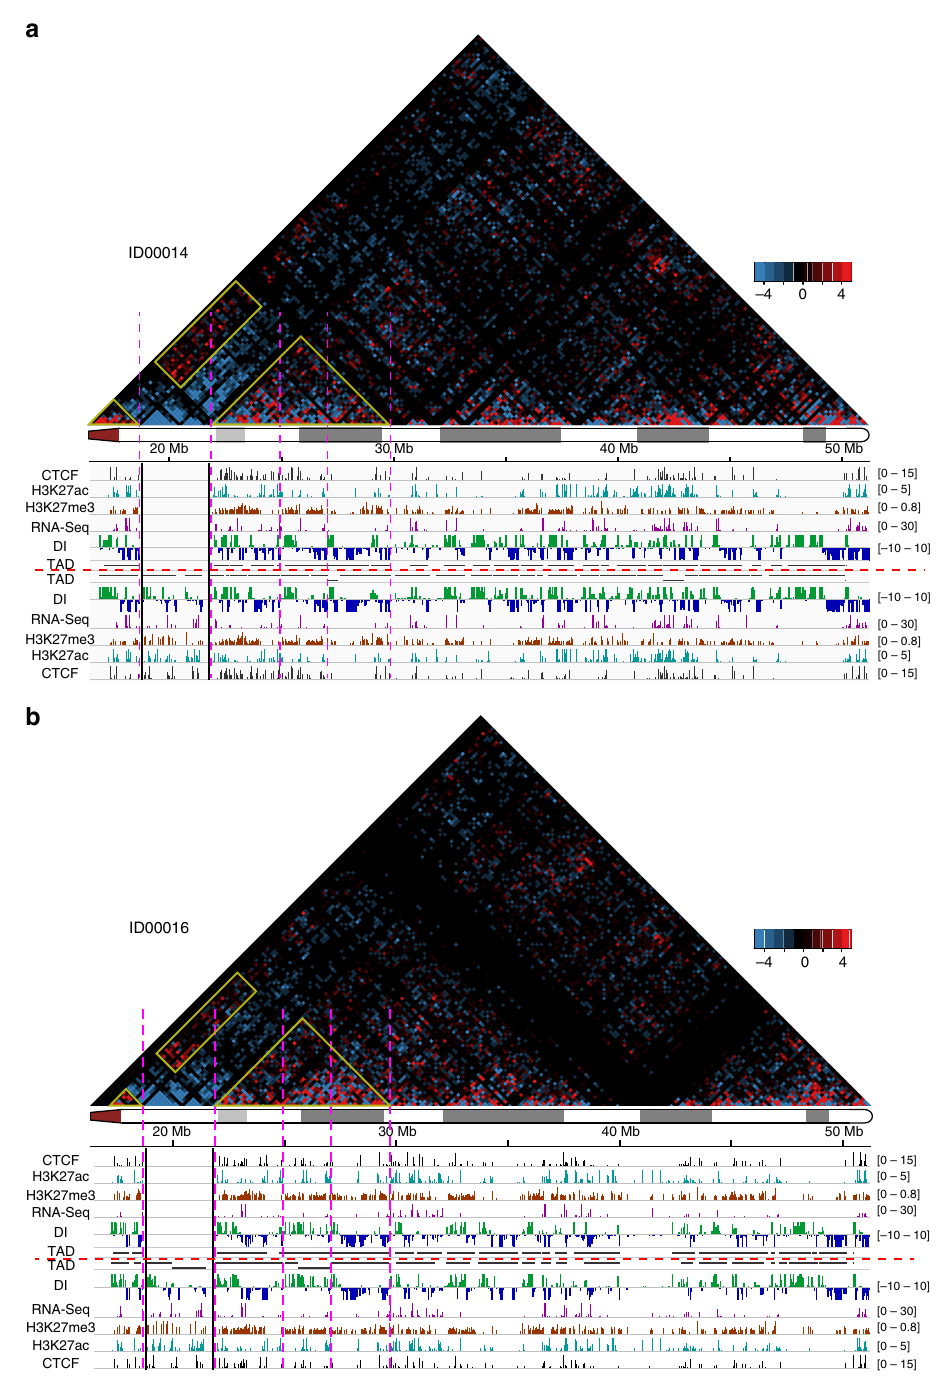
Fig. 4 Differential chromosome contacts for the two chromosomes 22q and haplotype-speci fi c topological domains for two patient cell lines. a Patient ID00014, b Patient ID00016. Heatmaps with bin size 200 kbp are showing the intra-chromosomal contacts on the homologous chromosome 22q with the 22q11.2 deletion minus the intra-chromosomal contacts on the intact chromosome 22q. The color scale of the heatmap goes from − 5 (blue) to 5 (red) with 0 represented by black. Yellow rectangles mark the increased contacts between the topological domains proximal and distal of the 22q11.2 region on the homologous chromosome 22q with the deletion (the topological domain on the proximal side of the deletion increases its contact not just with the topological domain immediately distal of the deletion, as predicted, but also with the two following topological domains). Yellow triangles and pink dashed lines mark the topological domains involved in the increased contacts. Black lines mark the boundaries and extent of the 22q11.2 deletion. Signal tracks for CTCF binding, histone marks, RNA-Seq, direction indices (DIs), and topological domains are shown twice, for the chromosome 22q with deletion (above dashed red line) and for the intact chromosome 22q (below dashed red line). Direction indices (DIs) are calculated at 40-kbp resolution for each homologous chromosome 22q. Haplotype-speci fi c gene expression, histone modi fi cations, and CTCF binding, respectively, are shown after normalizing the reads to 10 million read pairs. RNA-Seq and ChIP-Seq read-count bars within the boundaries of the deletion but from the intact chromosome 22q are shown for loci where there are phased SNVs in